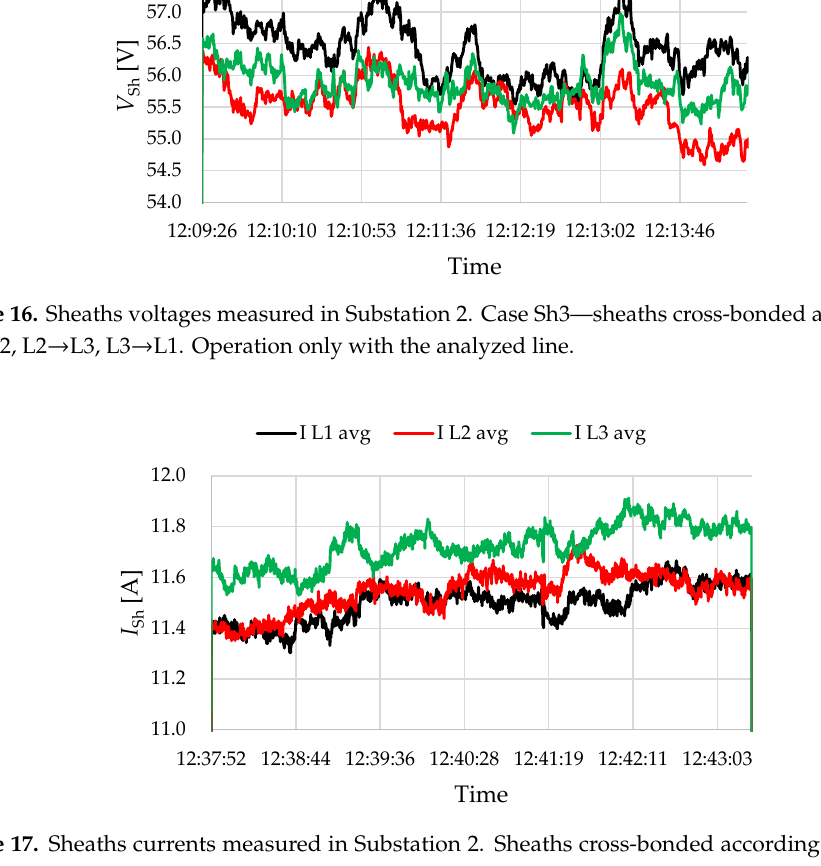
Figure 16. Sheaths voltages measured in Substation 2. Case Sh3—sheaths cross-bonded according to: L1 → L2, L2 → L3, L3 → L1. Operation only with the analyzed line.